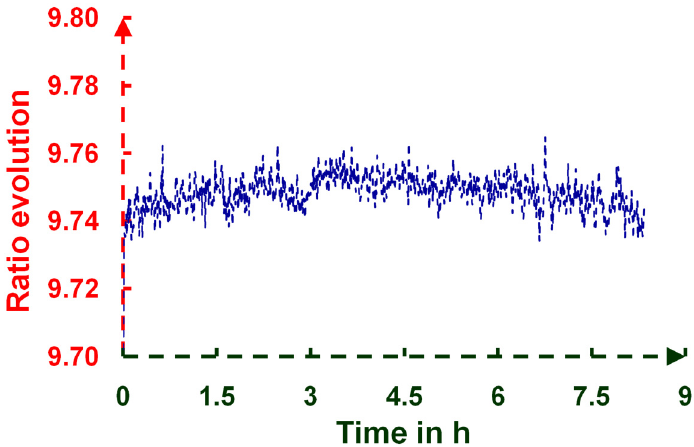
Figure 8. Signal fluctuations with a ratio between the reflection and the reference signals over 9 h.